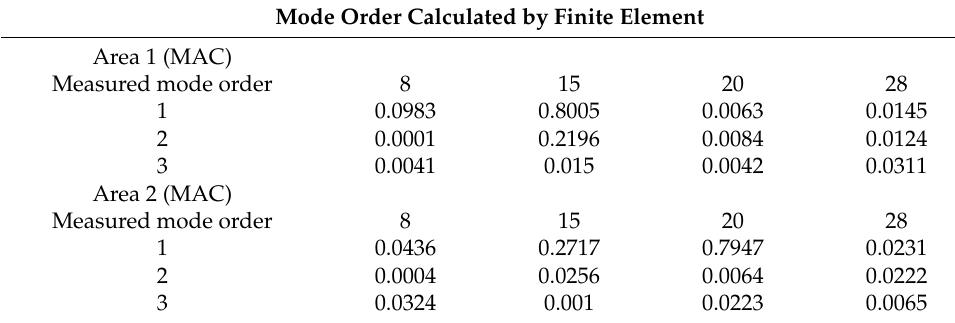
Table 5. MAC of actual measurement and finite-element calculation.